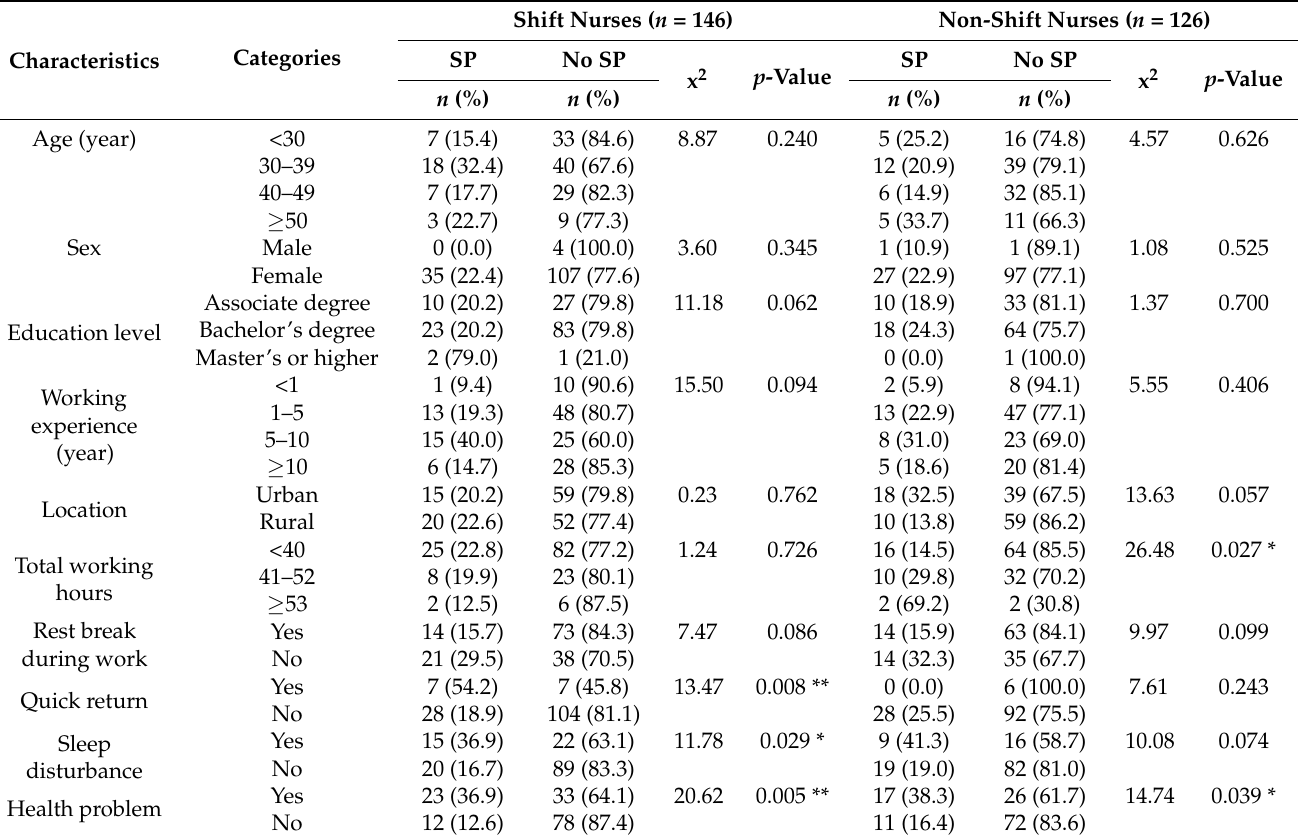
Table 2. Distribution of sickness presenteeism by shift work ( n =